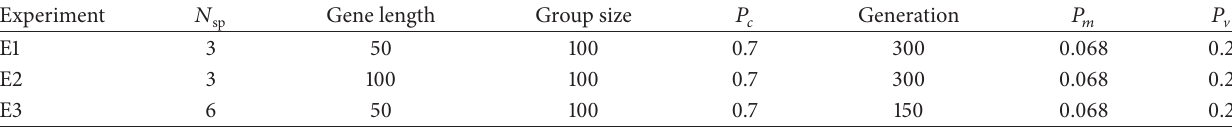
Table 1: Experiment of PMPGA with different subpopulation group and gene